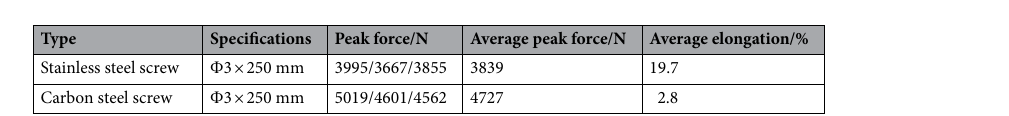
Table 2. Performance parameters of experimental bolts.